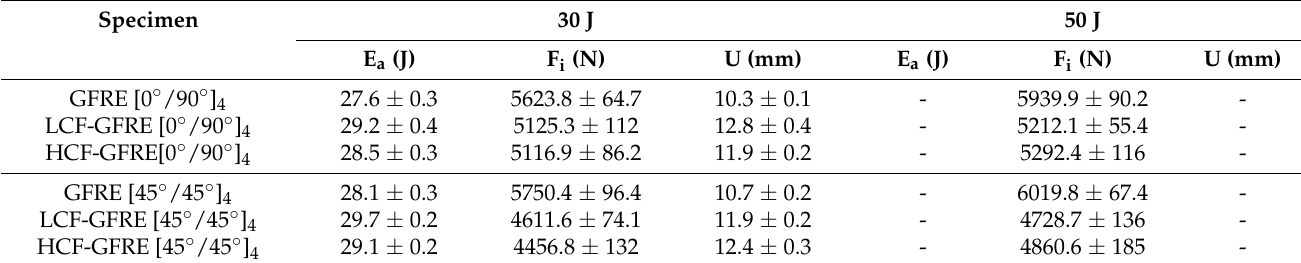
Table 4. Impact test results for all composite laminates at impact energy of 30 J and 50 J.